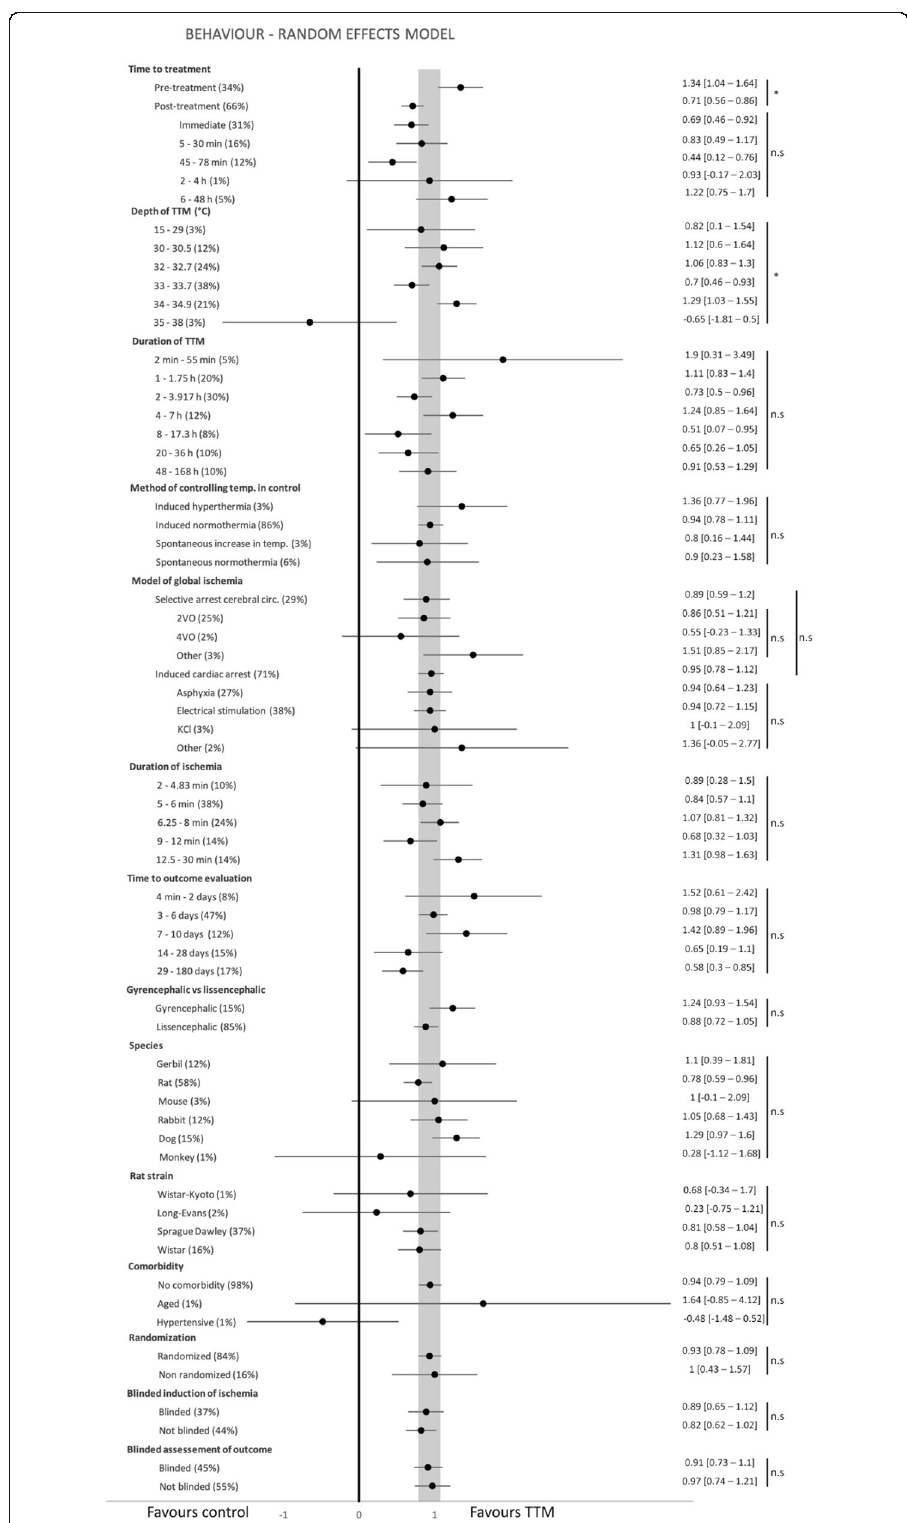
Fig. 4 (See legend on next